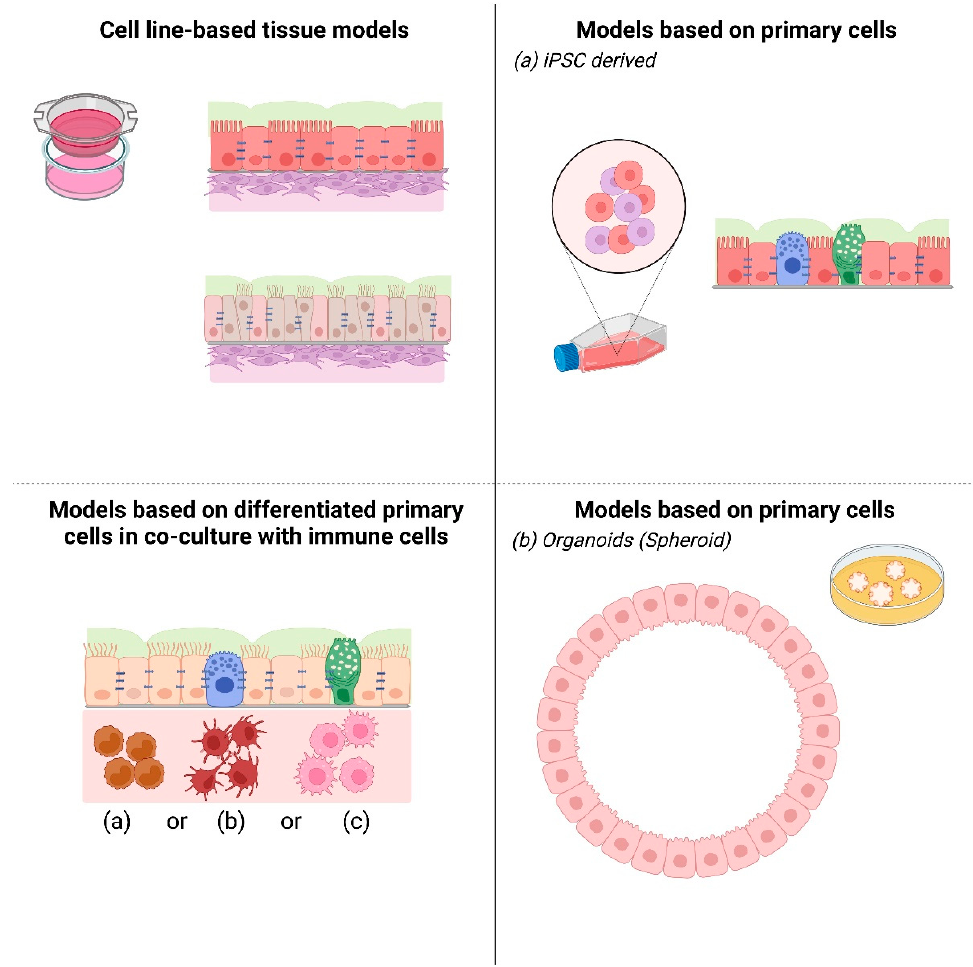
Figure 2. Schematic overview of 3D airway tissue model systems. This tabular scheme summarizes available 3D airway tissue models: (1) upper left: cell line-based tissue model, (2) lower left: differentiated primary cell-based co-culture models with (a) monocytes, (b) dendritic cells, or (c) macrophages, (3) right: Primary cell-based models as (a) iPS-derived model and (b) organoid culture-derived model. This figure was created with BioRender.com (accessed on 07 December 2021).